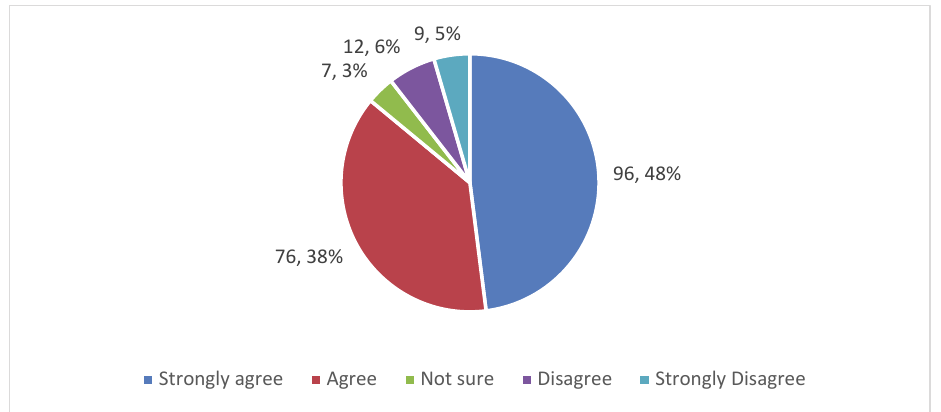
Fig. 2. Opinions on employee involvement and employee performances